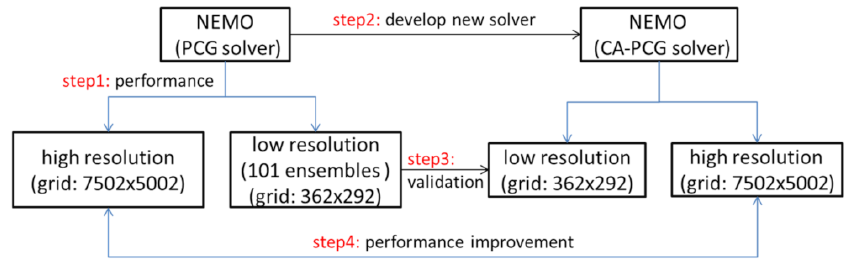
Figure 3. Flow chart of the experiments in this study. The experiments were designed in order of step1, step2, step3, and